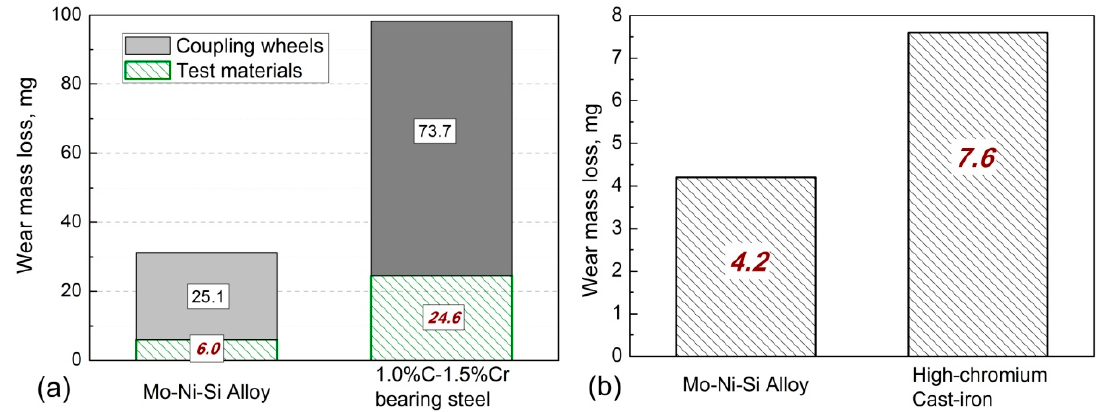
Figure 4. Wear mass loss of the Ni–Mo–Si ternary intermetallic composite and reference test materials under ( a ) room temperature dry-sliding and ( b ) abrasive wear conditions.